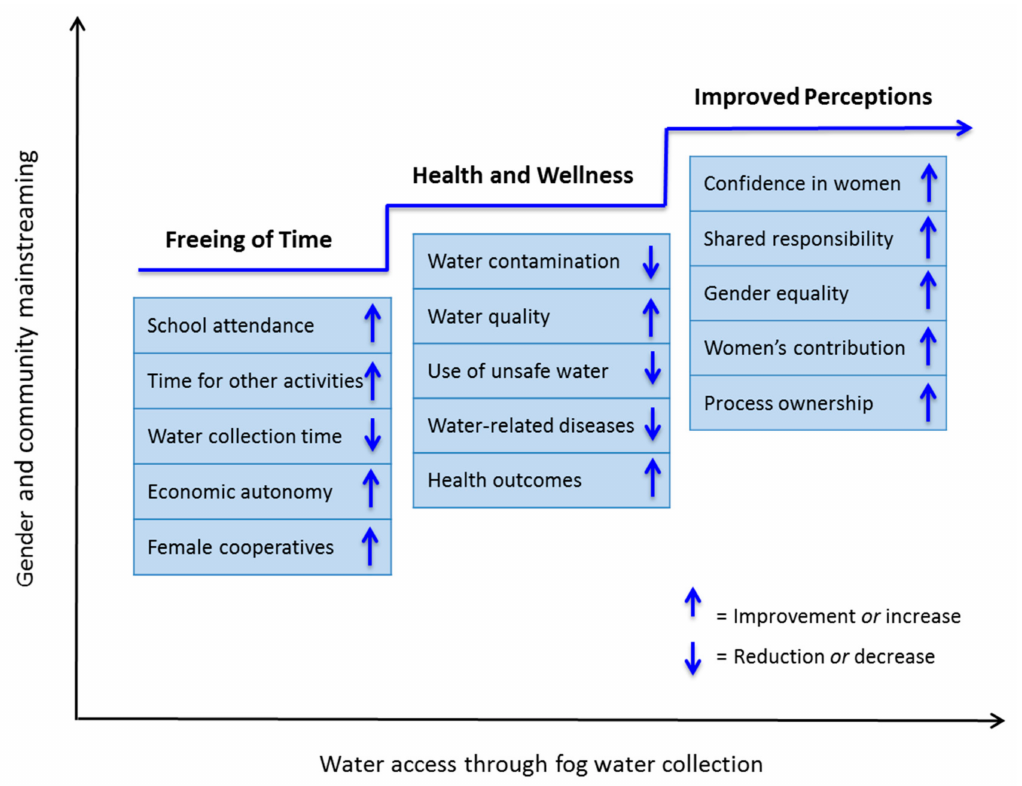
Figure 1. Key elements of gender and community mainstreaming through fog water collection projects showcasing a range of positive outcomes for the female segment of the communities moving from time-consuming and laborious water collection approaches to using fog water collection systems (Based on the empirical evidence and trends from fog water collection projects in different parts of the world in areas where weather conditions are favorable for fog